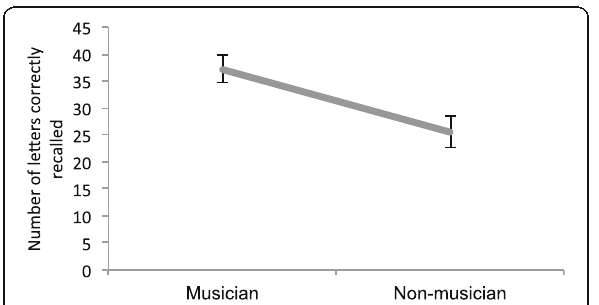
Fig. 1 Musician status in the reading span task. Musicians recalled more letters, that is, had a larger span, than non-musicians. Error bars represent SEM